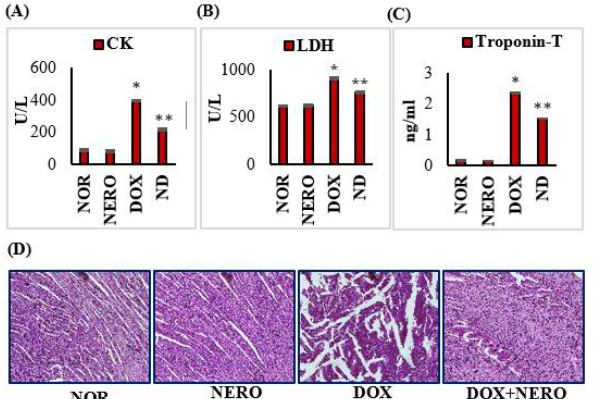
Figure 1. ( A – C ) Effect of NERO on myocardial injury markers; columns do not share a common symbol (*, **) and differ significantly from each other (* p < 0.05 vs. normal control, ** p < 0.05 vs. DOX control). ( D ). Histopathology of the myocardium: Normal control rat’s heart has normal architecture of the myocardium; NERO alone treated rat’s heart also shows normal intact muscle fibers without any pathological changes; DOX—injected rat’s heart shows extensive muscle fiber degradation with inflammatory cells; NERO treated DOX—challenged rats shows a reduced muscle fiber degradation without inflammatory cells. CK—creatine kinase; LDH—lactate dehydrogenase; NOR—normal; NERO—nerolidol; DOX—doxorubicin; ND—rats administered with a single intraperitoneal dose of DOX and orally treated with NERO. DOX administered rats showed a significant ( p < 0.05) increase in malondialdehyde (MDA) content with a significant ( p < 0.05) decrease in the activities/concentrations of su- peroxide dismutase (SOD), catalase, and reduced glutathione (GSH), at least when com- pared to the normal control rats. Moreover, DOX-injected rats showed a significant ( p < 0.05) decrease in the expressions of myocardial proteins, heme oxygenase-1 (HO-1) and Nrf2 demonstrated a significant ( p < 0.05) increase in the expression of Kelch-like ECH- associated protein 1 (Keap-1) in the myocardium compared to the normal control rats. However, rats treated with NERO showed a significant ( p < 0.05) reduction in MDA levels and a significant ( p < 0.05) increase in the activities/concentration of SOD, catalase, and GSH, at least when compared to the DOX control rats. NERO treatment also showed a significant ( p < 0.05) increase in the expressions of myocardial proteins. HO-1 and Nrf2 had a significant ( p < 0.05) decrease in the myocardial protein expressions of Keap-1 in DOX-injected rats compared to DOX control rats (Figure 2).